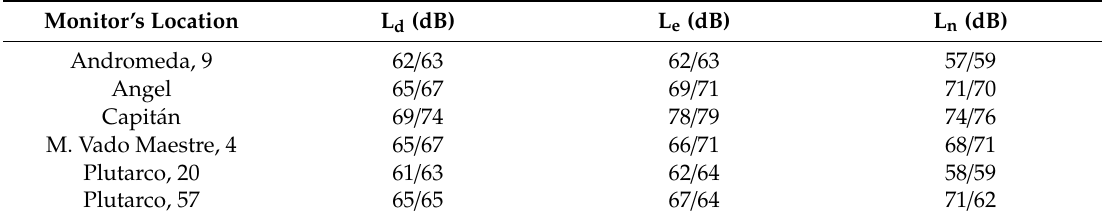
Figure 13. Box plot diagram to compare the measurements between instruments. Table 7. Ld, Le, and Ln levels. The left values are from low-cost monitors and the right values are from the type 1 monitors used as a